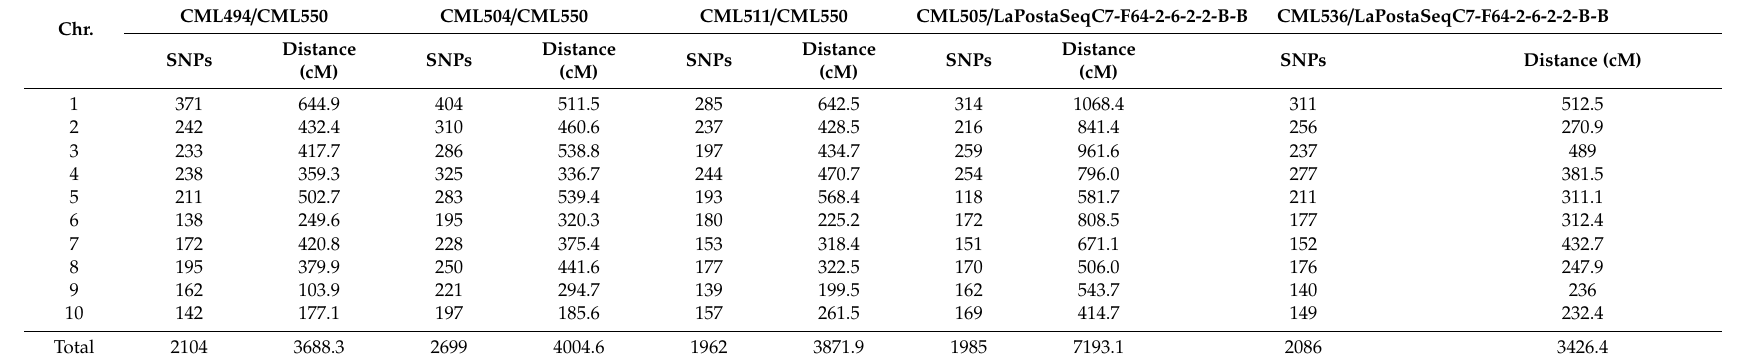
Table 1. Number of markers and total map distance observed in each population used for QTL analysis. Chr.